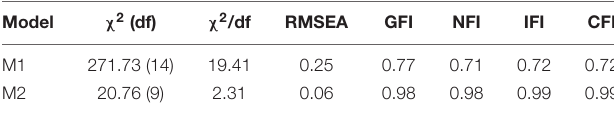
TABLE 6 | Results of the two competing models in Study 2 ( N =